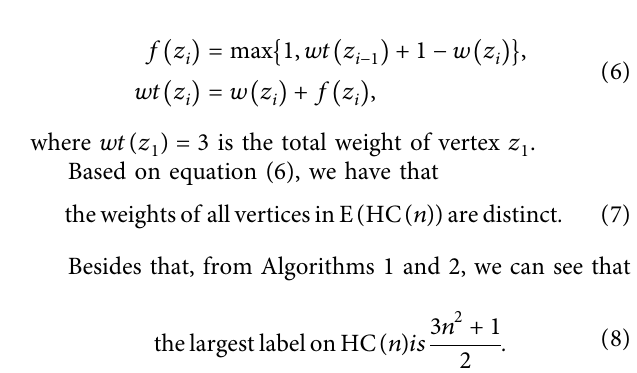
A LGORITHM 4: Algorithm for labeling all other edges in